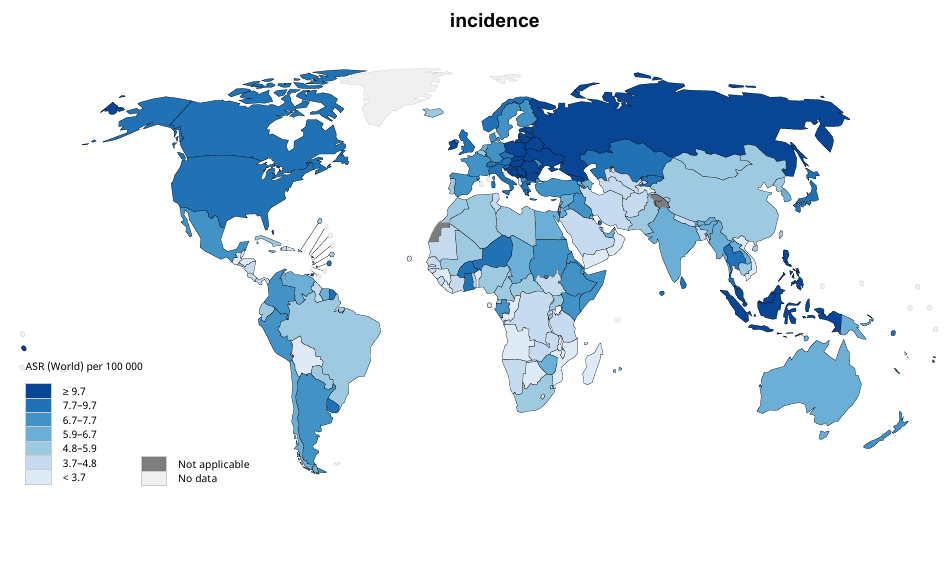
Figure 1. Global incidence and mortality of ovarian cancer, all ages, in 2020